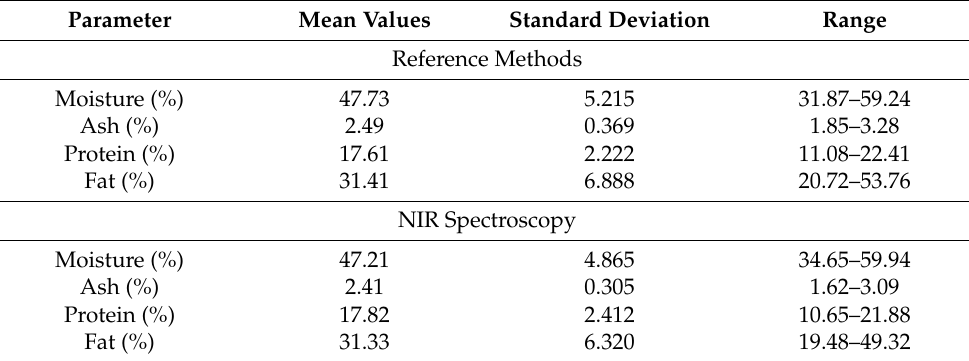
Table 1. Chemical composition according to the reference measurements and NIR spectroscopy for the calibration set of samples (n =